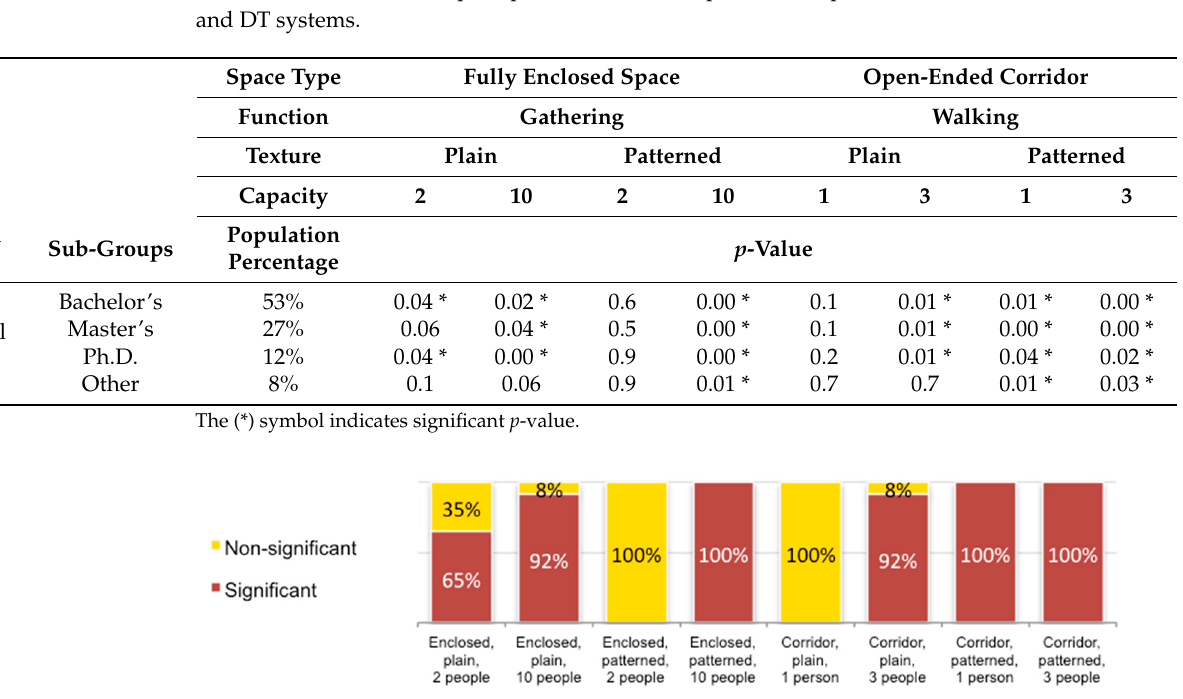
Figure 6. Percentage of participants with significant/non-significant size variations for each space in educational level perception filter.